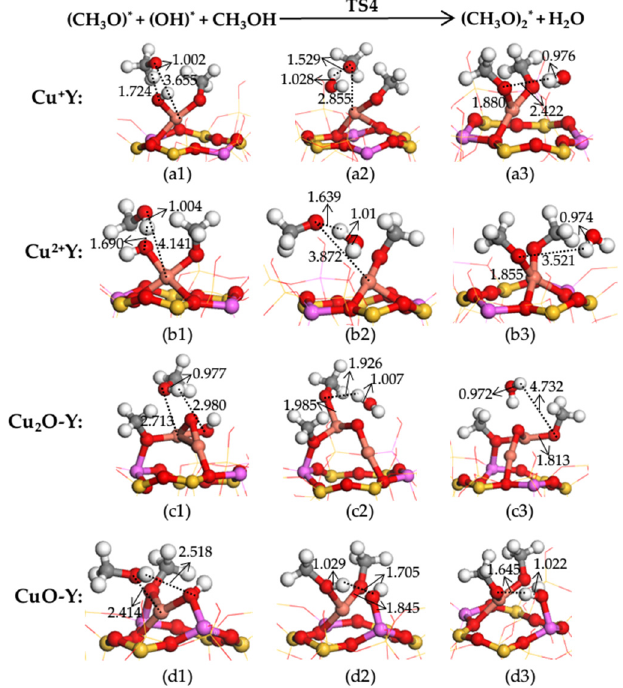
Figure 8. The structures of reactants, products and transition states on Cu + Y, Cu 2+ Y, Cu 2 O-Y and CuO-Y zeolite for the formation of (CH 3 O) 2 (unit: Å). ( a1 ) (CH 3 O) * /(OH) * /CH 3 OH on Cu + Y, ( a2 ) TS4